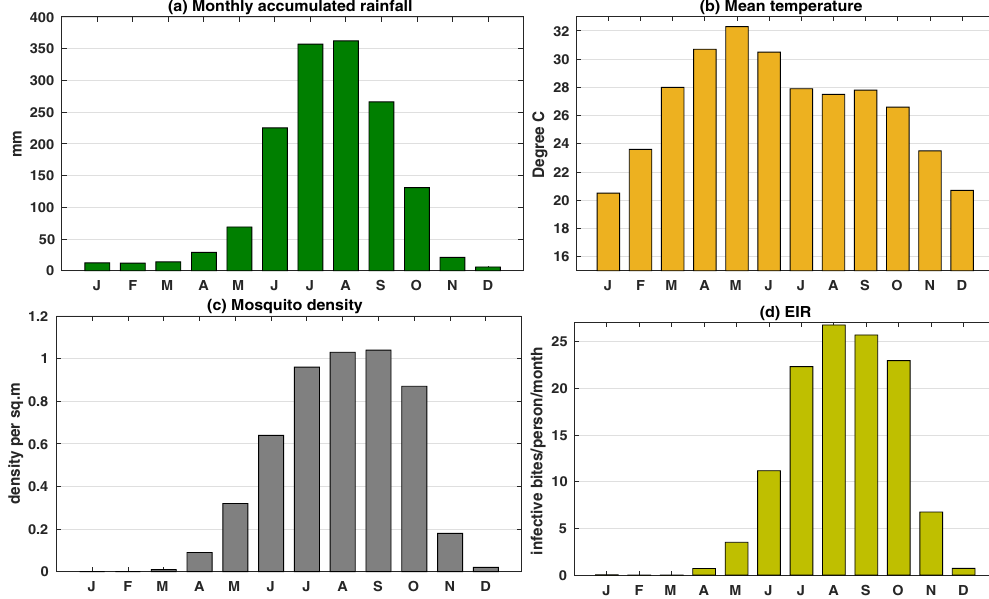
Figure 4. Monthly variations in VECTRI-simulated. ( a ) Accumulated rainfall, ( b ) surface mean temperature, ( c ) mosquito density, and ( d ) EIR, over Odisha. The graphs correspond to the averaging period of 2000–2013.